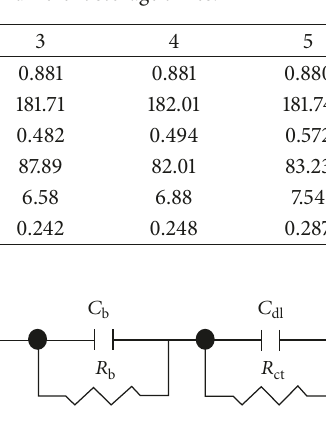
Figure 5: Nyquist and Bode plots for 304 stainless steel evaluated in biodiesel at 110 ∘ C. Table 3: The physicochemical parameters of biodiesel after different storage times.